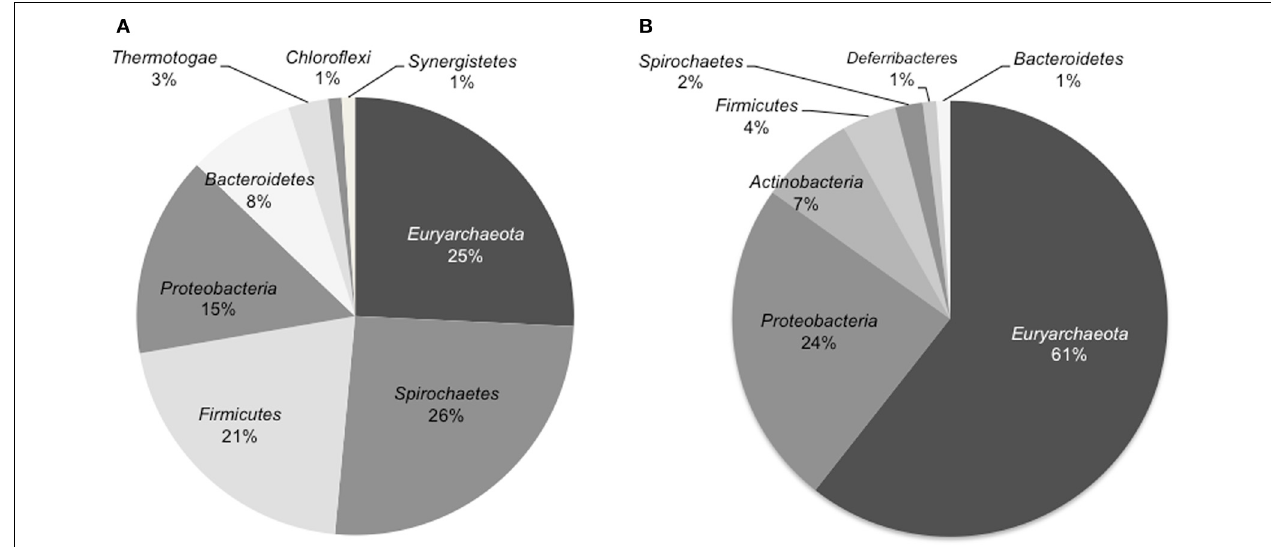
FIGURE 4 | Distribution of microbial sequence reads from pyrosequencing analysis identified at the phylum level of the 16S rRNA genes in the oil degrading methanogenic culture (A) and in the inoculated sand-packed column (B). Only abundances higher than 1% are shown.